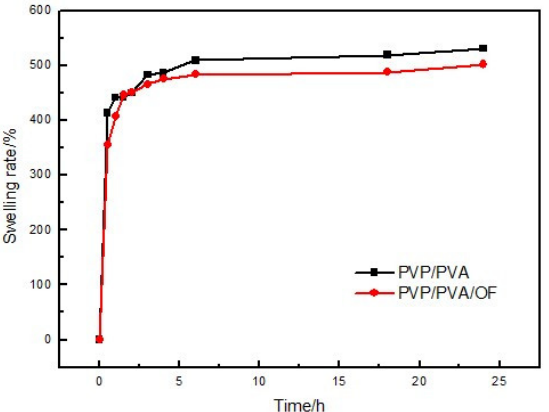
Figure 5. The swelling rate of PVP/PVA hydrogel and OF/PVP/PVA hydrogels with a concentration of 100 μg/mL.